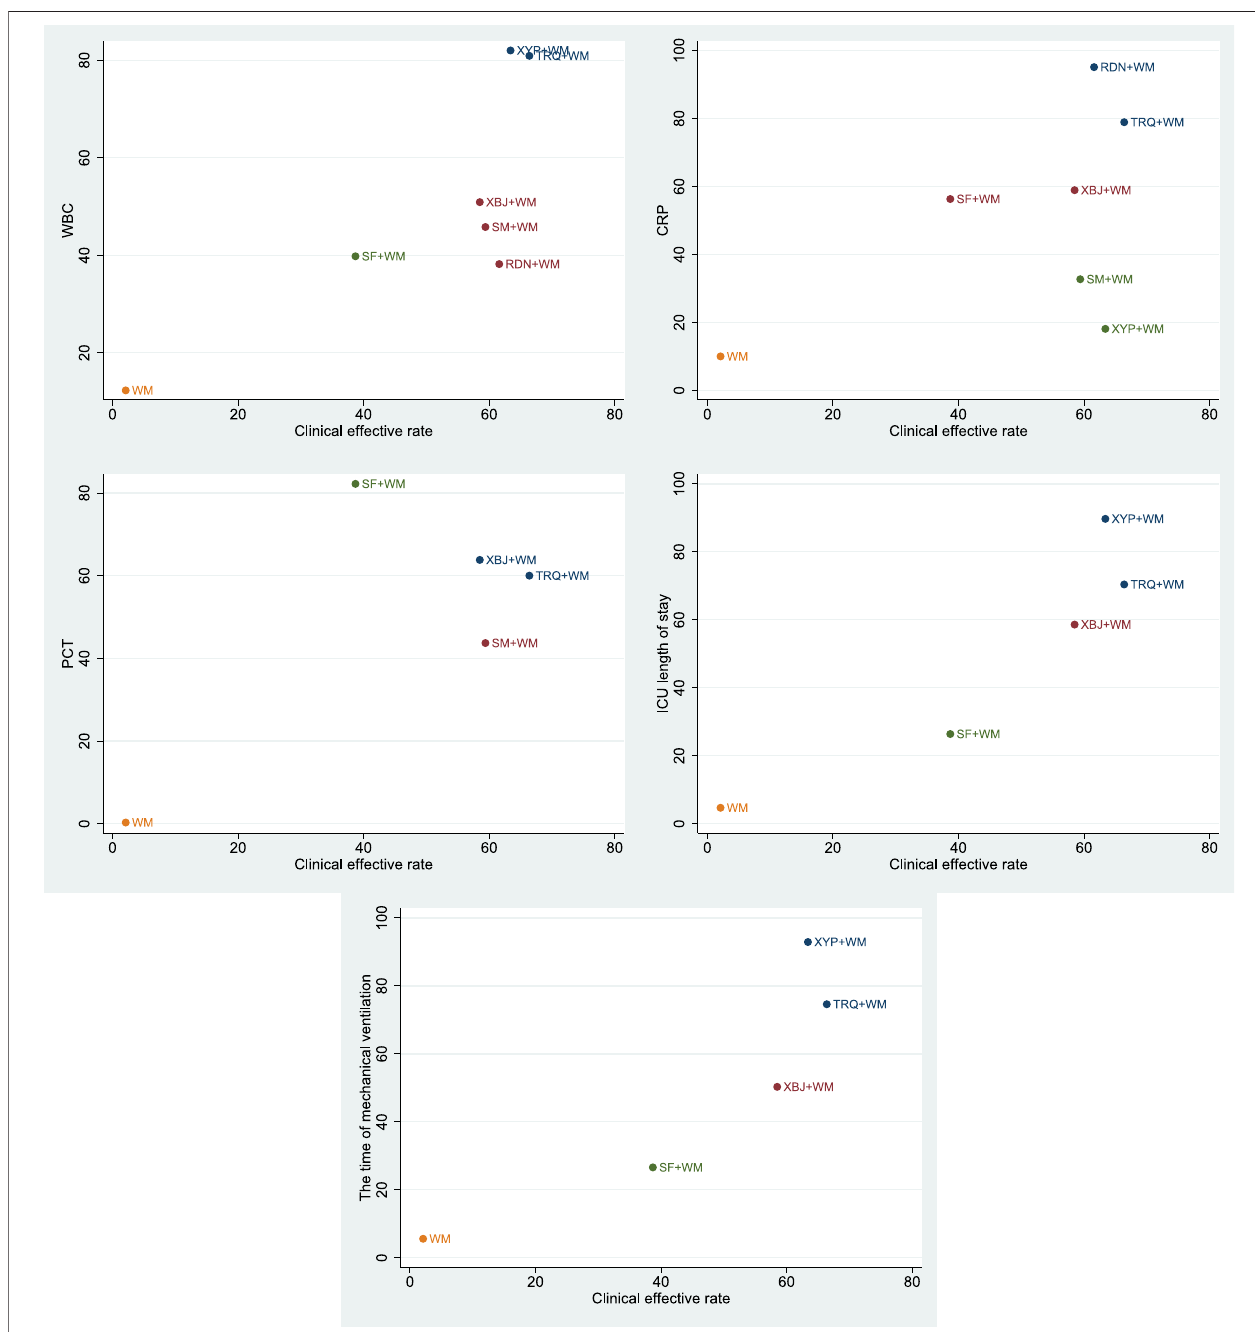
FIGURE 6 | Cluster analysis plot for six outcomes. Note: interventions with the same color belong to the same cluster, and interventions located in the upper right corner indicate optimal therapy for two different outcomes.